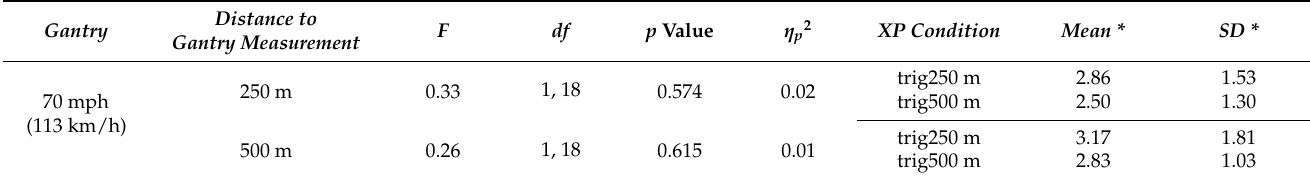
Table 11. Analysis of variance to test the mean speed homogeneity of both groups in the noHMI baseline